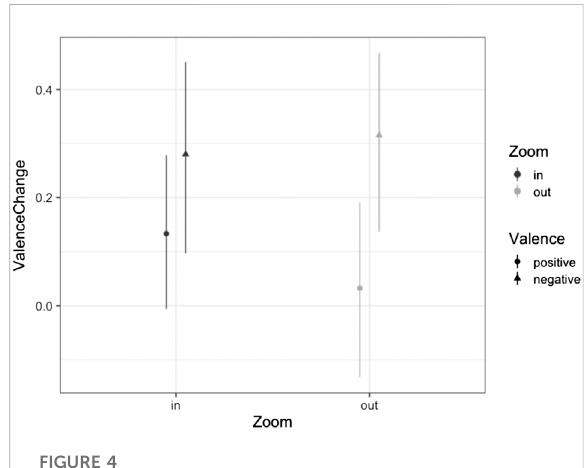
FIGURE 4 Mean Values of Valence Change as a function of zoom and valencecategoriesofthepicturesforExperiment2.Barsrepresent the 95% Con fi dence